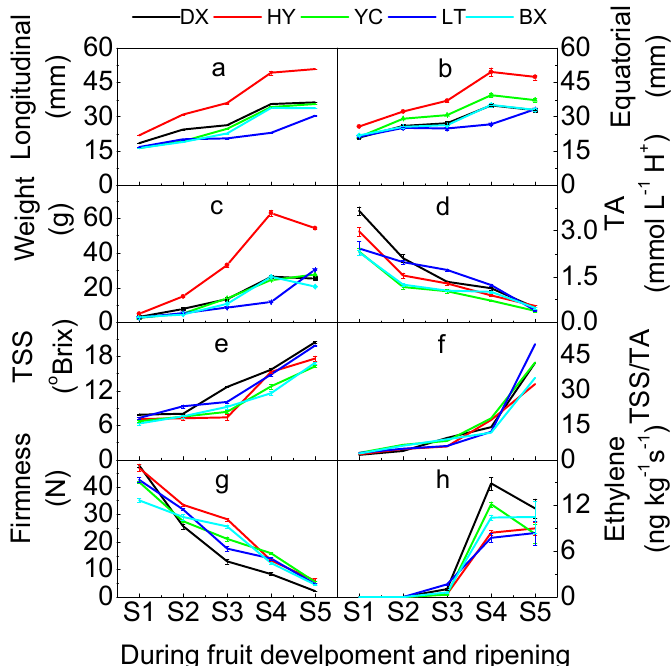
Figure 2. Fruit quality traits of apricots during development and ripening. ( a ) Fruit longitudinal diameter; ( b ) Fruit equatorial diameter; ( c ) Weight of single fruit; ( d ) TA, titratable acid; ( e ) TSS, total soluble solid; ( f ) TSS/TA, the ratio of TSS and TA; ( g ) Fruit firmness; ( h ) Ethylene production. All data are expressed as means ± standard error of triplicate samples.